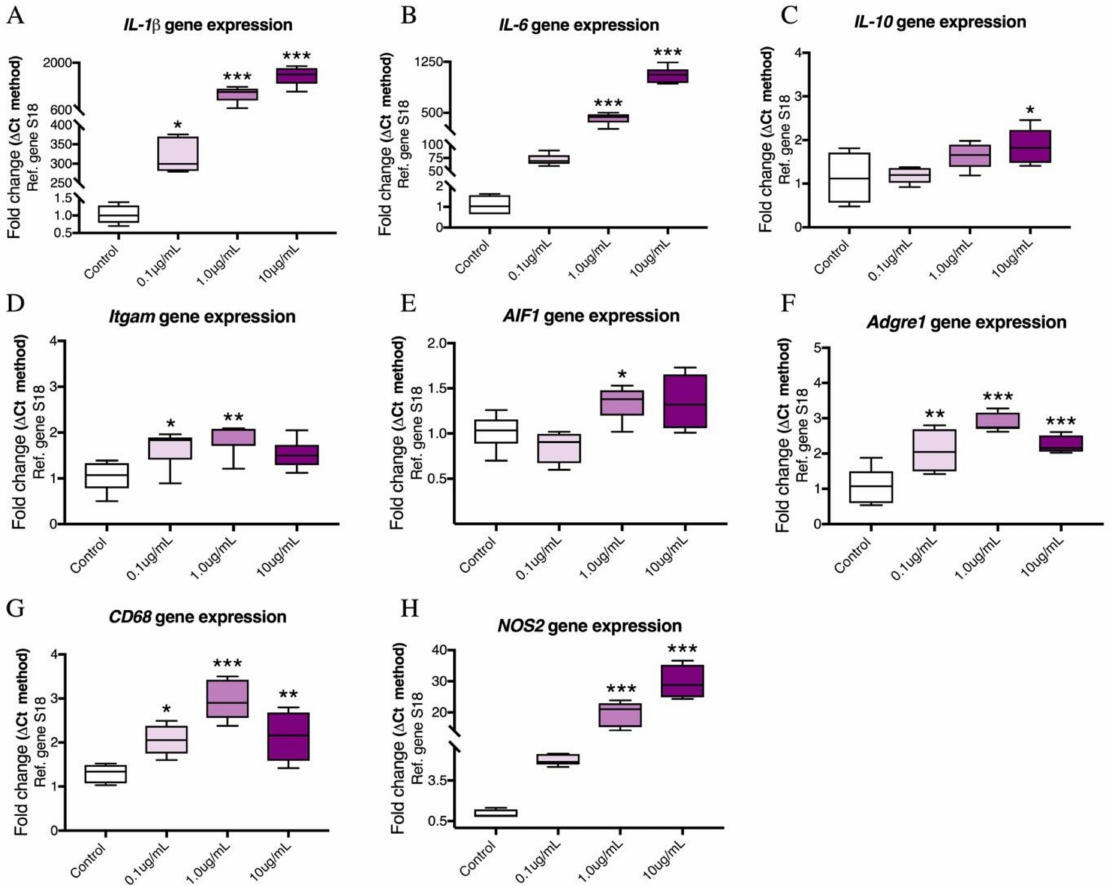
Figure 1. LPS titration experiments showing dose-dependent changes in mRNA expression levels of pro-inflammatory markers in BV2 cells. Murine BV2 cells were serum starved for 24 h prior to treatment with 0.1 µ g/mL, 1.0 µ g/mL and 10 µ g/mL of LPS for 24 h, shown with no LPS controls. RNA was extracted by TRISURE reagent and reverse transcribed into cDNA. The mRNA levels of ( A ) IL-1 β , ( B ) IL-6 , ( C ) IL-10 , ( D ) Itgam , ( E ) AIF1 , ( F ) Adgre1 , ( G ) CD68 and ( H ) NOS2 were determined by real-time qPCR, using S18 as an internal housekeeping gene. Levels were quantified using the Delta-CT method. Data represent means of 4–6 samples for each group. Results are expressed as mean ± SEM. * p < 0.05, ** p < 0.01, *** p < 0.001 vs. control as determined by one-way ANOVA followed by Dunnett’s post hoc test. ( Gene : protein acronyms): IL-1 β : Interleukin 1 β , IL-6 : Interleukin 6, IL-10 : Interleukin 10, Itgam : CD11b, AIF1 : Iba1, Adgre1 : F4/80, CD68 : Cluster of differentiation 68 (CD68), NOS2 : inducible nitric oxide synthase (iNOS), S18 : ribosomal protein